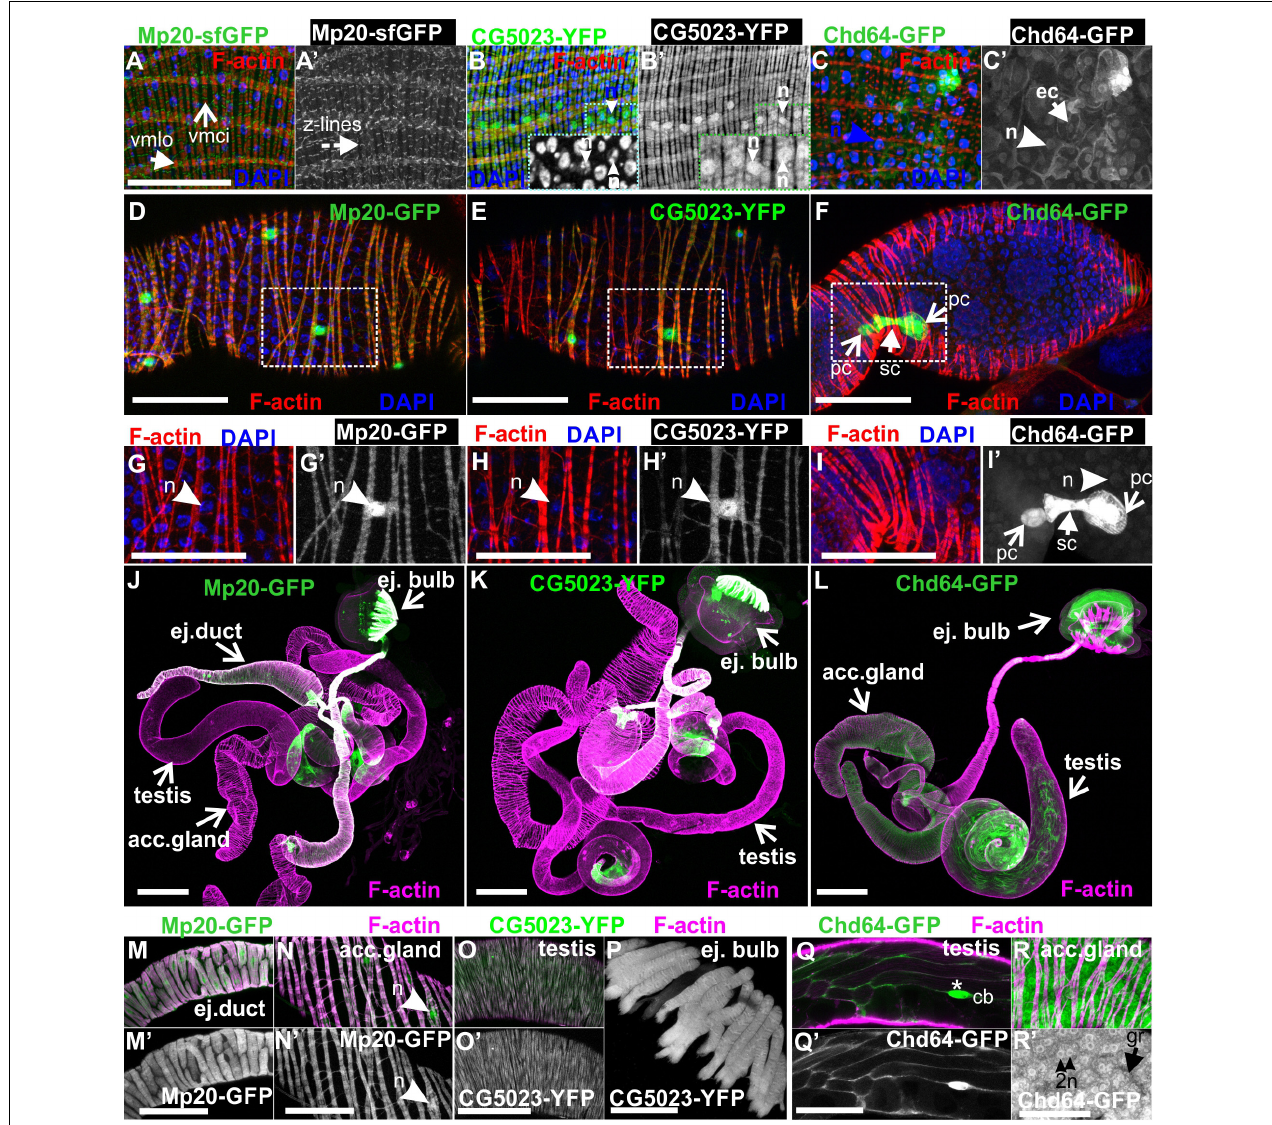
FIGURE 9 | Transgelins expression in adult gut and genitalia. (A,A (cid:48) ,B,B (cid:48) ,C,C (cid:48) ) Tangential confocal sections of adult midgut regions expressing Mp20-sfGFP, CG5023-YFP, and Chd64-GFP. (A,A (cid:48) ) Mp20-sfGFP expression is observed in the Z-lines of both visceral circular and longitudinal muscle layers (vmci and vmlo respectively), whereas (B,B (cid:48) ) CG5023-YFP accumulates solely in the vmci showing nuclear localization along with colocalization to filamentous actin. (C,C (cid:48) ) Chd-GFP intestinal subcellular localization appears prominent in both the nucleus and cytoplasm of enterocytes. (D–F) Mp20-GFP, CG5023-YFP, and Chd64-GFP expression pattern in egg chambers of adult female genitalia. (D) Mp20-GFP and (E) CG5023-YFP are both expressed in muscle sheath surrounding the egg chambers, whereas (F) Chd64-GFP localizes in polar and follicle cells. (G–I,G (cid:48) –I (cid:48) ) High magnification egg chambers expressing (G,G (cid:48) ) Mp20-GFP and (H,H (cid:48) ) CG5023-YFP both showing considerable nuclear localization and circular visceral muscle accumulation, while (I,I (cid:48) ) Chd64-GFP accumulation is specific to polar and follicle cells. (J–L) Mp20-sfGFP, CG5023-YFP, and Chd64-GFP expression pattern in multiple regions of adult male genitalia. (M–R) High magnification of male genitalia compartments expressing (M,N,M (cid:48) ,N (cid:48) ) Mp20-sfGFP and (O,O (cid:48) ,P) CG5023-YFP both apparent in (M,M (cid:48) ) the ejaculatory duct muscle sheath, (N,N (cid:48) ) the accessory gland muscle sheath, (O,O (cid:48) ) the smooth muscles surrounding testes and (P) the ejaculatory bulb muscle fibers. (Q,R and Q (cid:48) -R (cid:48) ) Chd64-GFP expression in distinct cell types of male genitalia, particularly in (Q,Q (cid:48) ) the testis, as well as in (R,R (cid:48) ) the binucleated accessory gland epithelium. (R,R (cid:48) ) Chd64-GFP subcellular localization appears both nuclear (R (cid:48) ) and cytoplasmic (R (cid:48) ) in either type of these cells. Each image is representative of at least 4 different imaged adults or adult tissues of the same genotype and markers used. vmlo, longitudinal visceral muscles; vmci, circular visceral muscles; pc, polar cell; fc, follicle cell; ej. duct, ejaculatory duct; acc. gland, accessory gland; ej. bulb, ejaculatory bulb; acc. gland, accessory gland; cb, cystic buldge; gr, granule; n, nucleus Scale bars: 100 µ